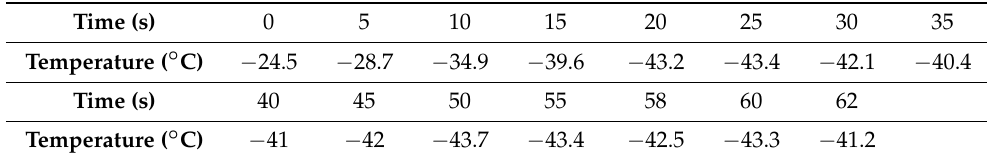
Figure 10. Temperature change curve over time in the response phase. Table 6. Variation of average temperature over time in the response